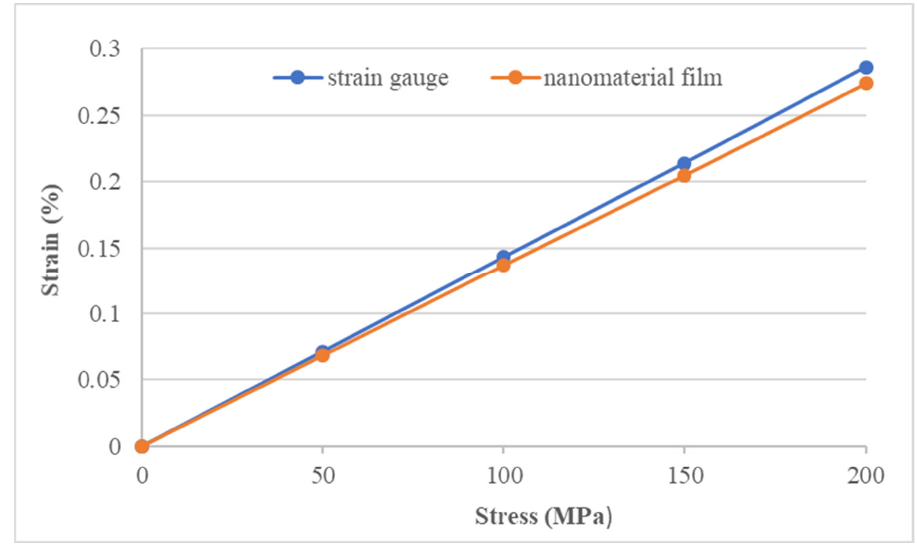
Figure 13. Strains of the Al specimen measured by the strain gauge and nanomaterial film sensor with strain sensitivity of 24.